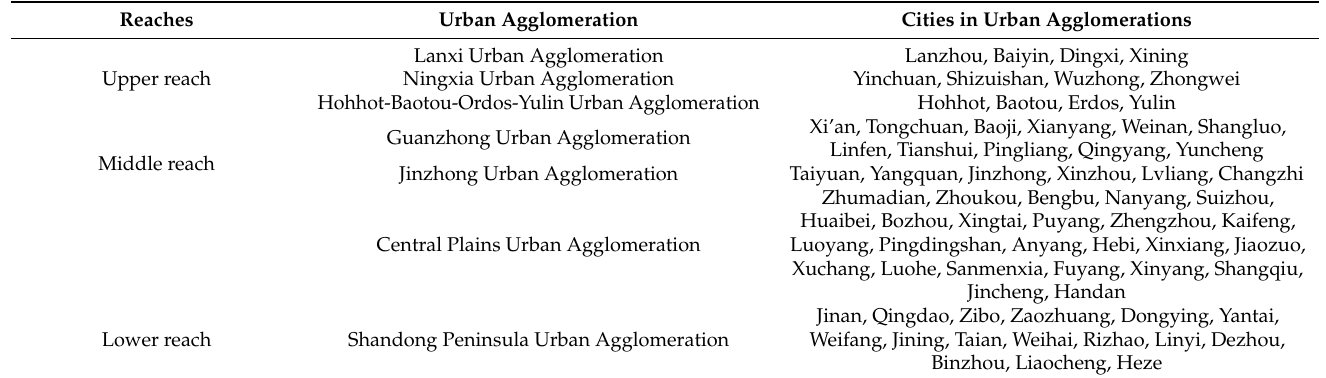
Table A2. Summary of urban agglomeration and their cities in the Yellow River